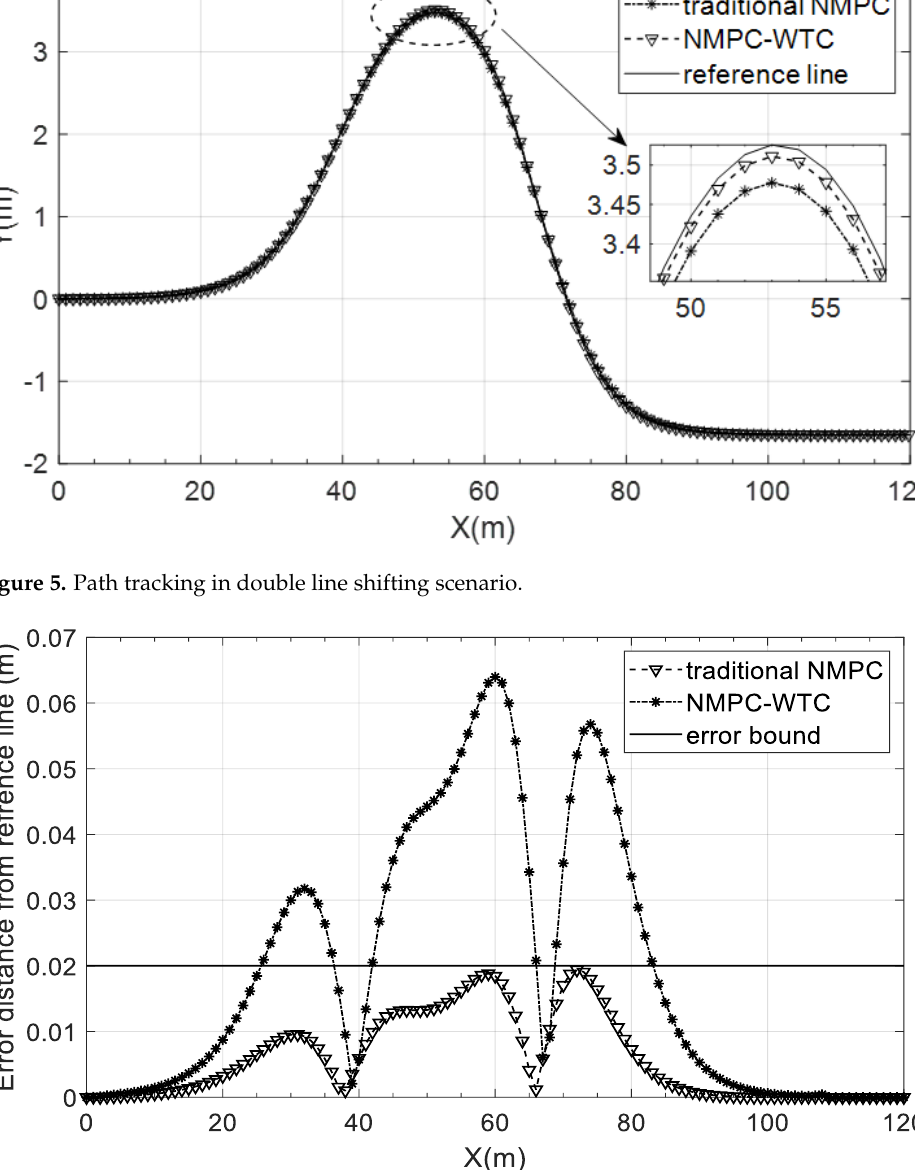
Figure 6. Path tracking error in double line shifting scenario.